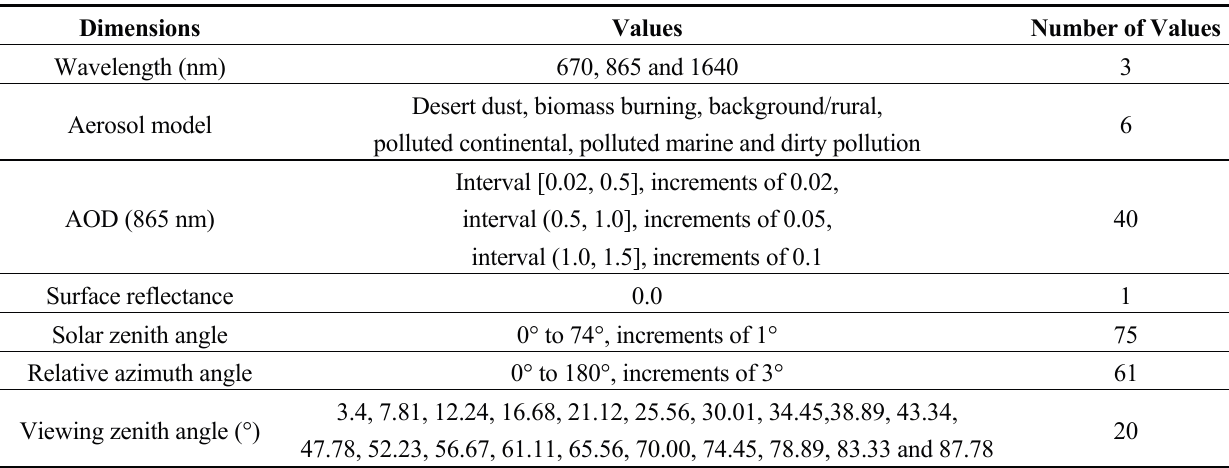
Table 3. Parameter setting for LUT. AOD, aerosol optical